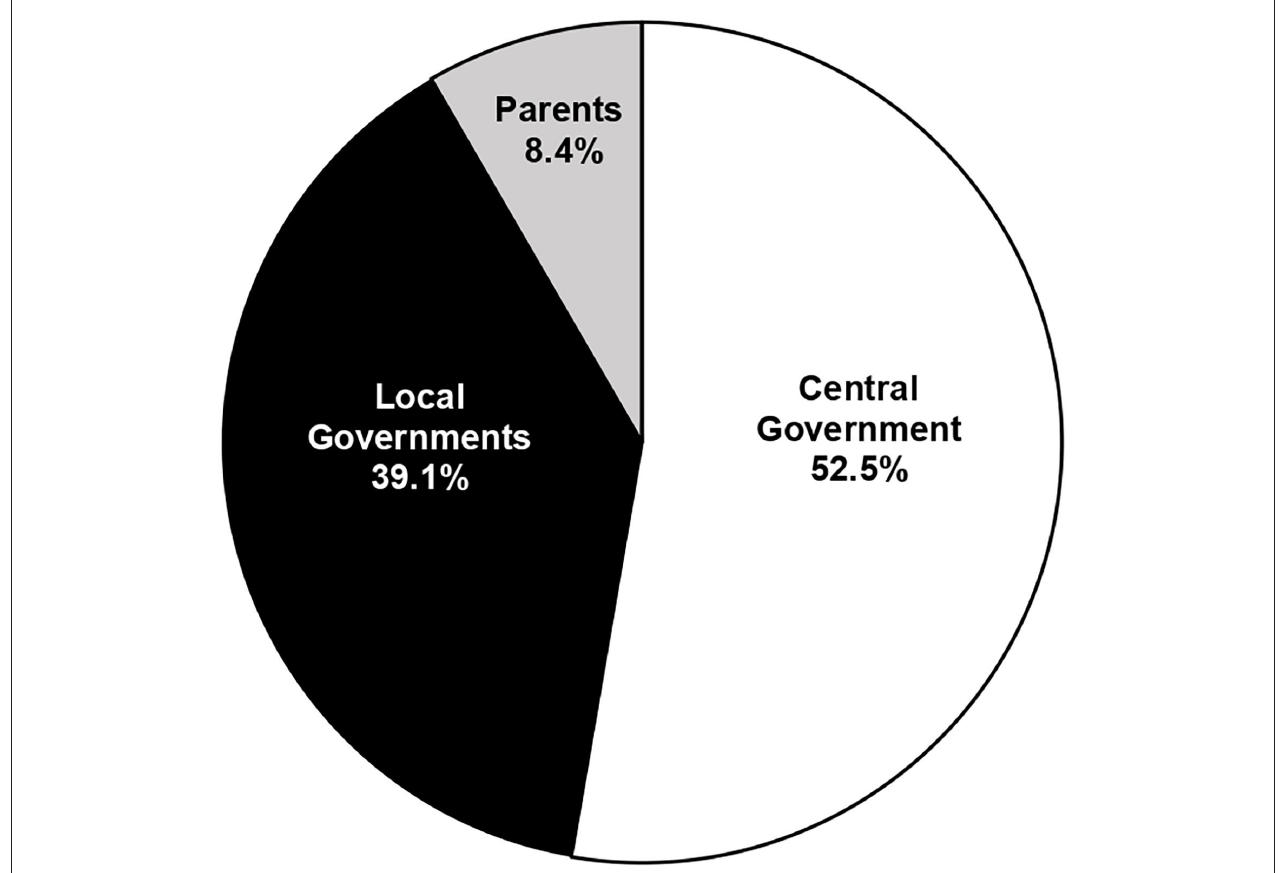
FIGURE 3 | Pie chart illustrating of who should decide about school closures obtained from the Survey of Opinions of School Closures during the Current COVID-19.